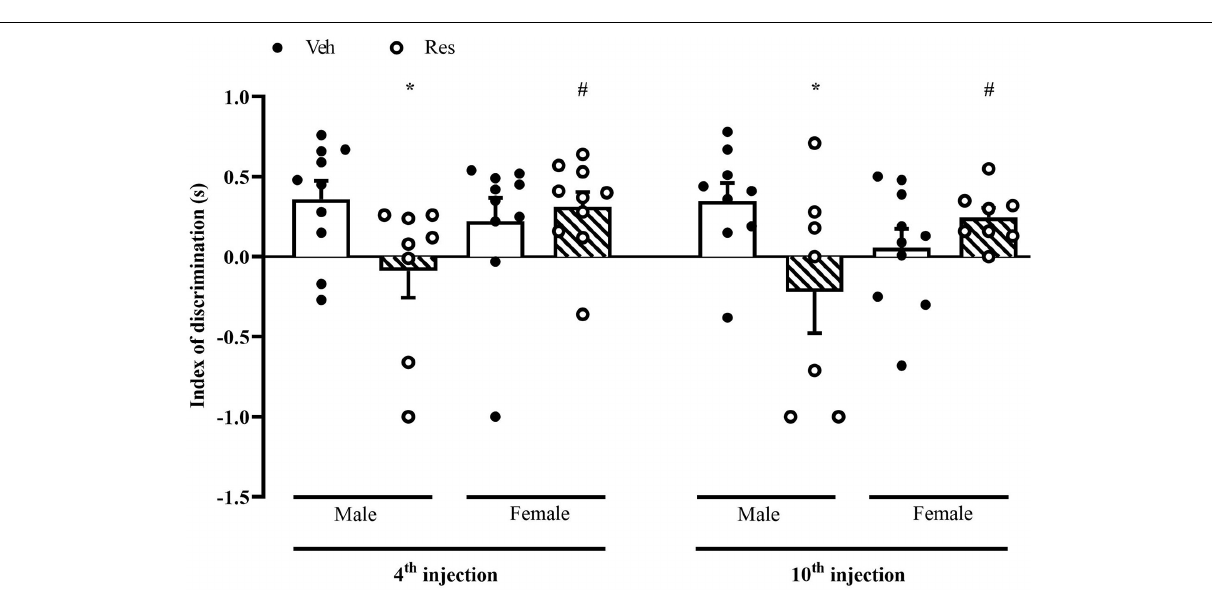
FIGURE 5 | Effects of repeated treatment with of 0.1 mg/kg reserpine (Res) or vehicle (Veh) on object recognition memory in female and male rats. * p < 0.05 comparing Res and Veh # p < 0.05 comparing Male-Res and Female-Res (Two-way ANOVA followed by Sidak’s post hoc test). Values were expressed by mean ± SEM. Black and circles represent individual data of Veh and Res animals,